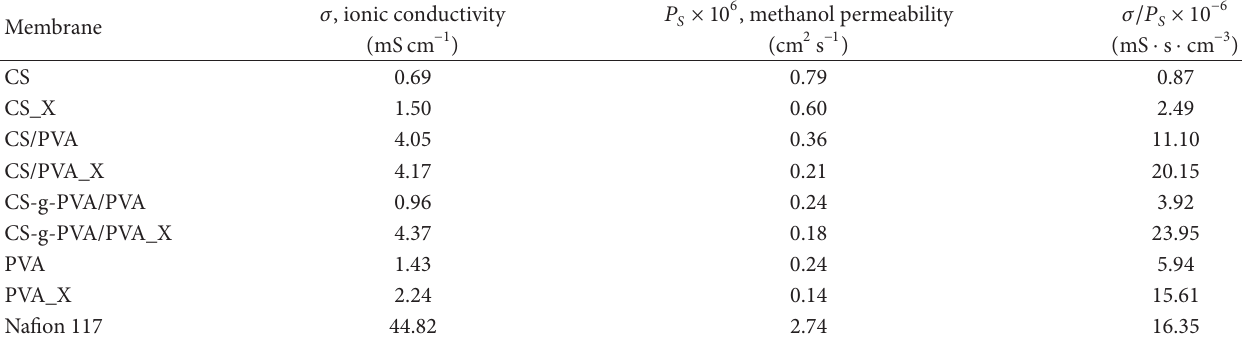
T 4: Ionic conductivities from the impedance method, methanol permeabilities, together with the selectivities,